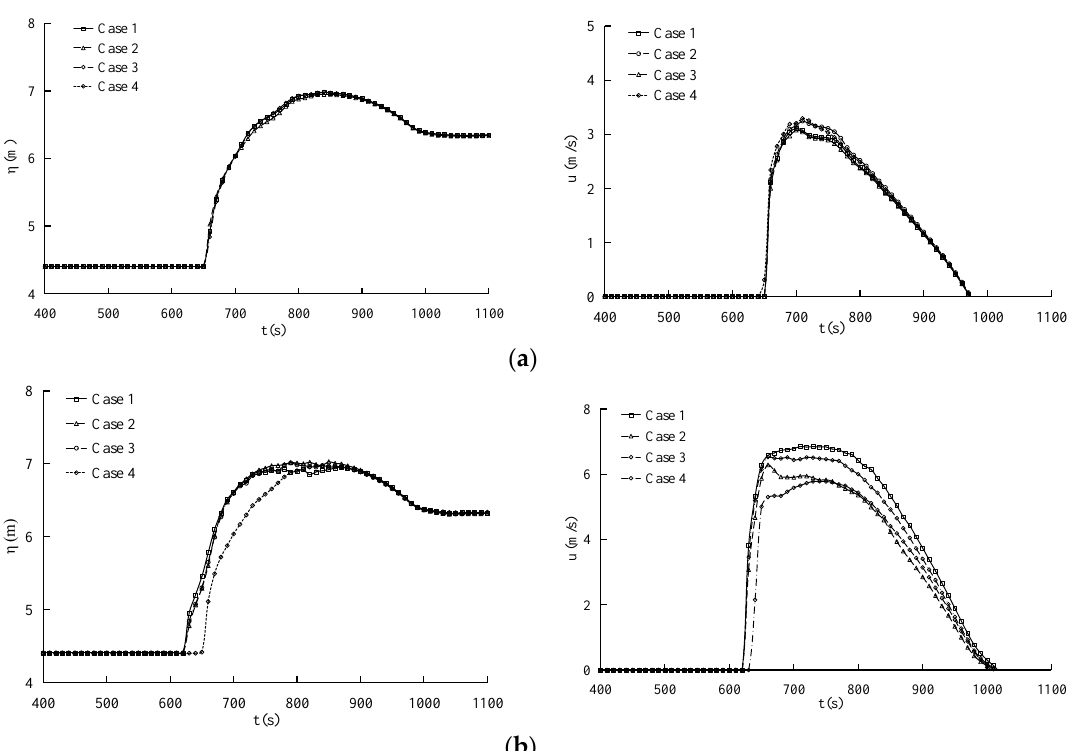
Figure 15. Temporal variation of surface water elevations and current velocities at ( a ) = G3 and ( b ) = G4.